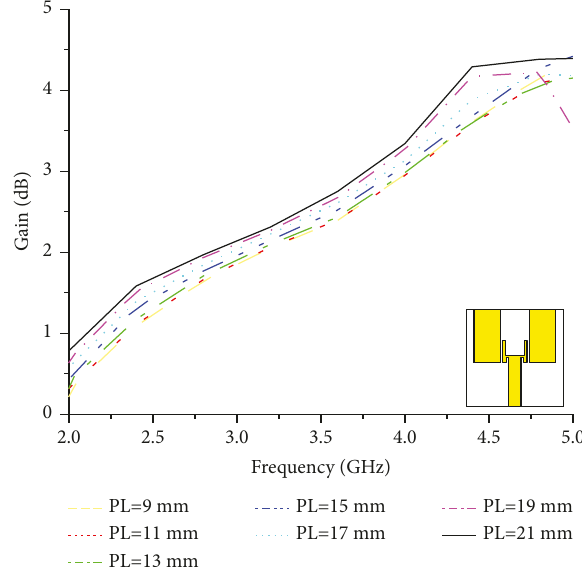
Figure 9: Variation of the gain for different length of parasitic element on the ground plane ( P